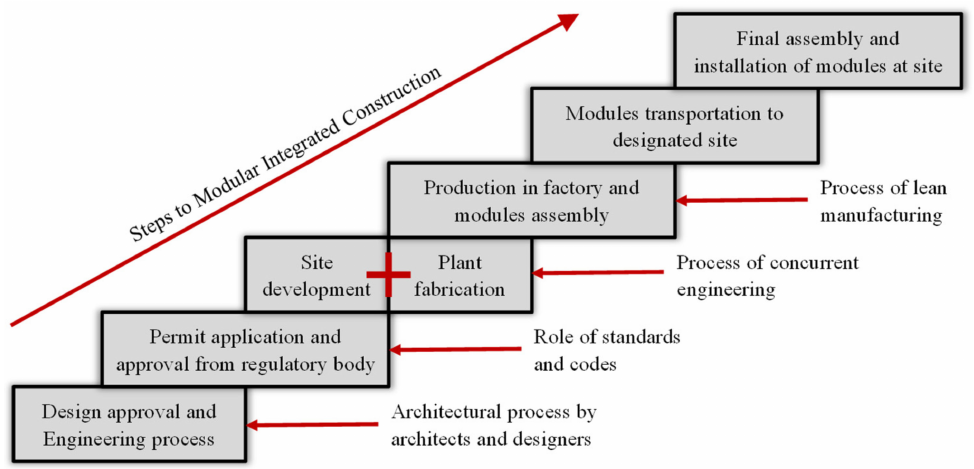
Figure 2. Steps of Modular Integrated